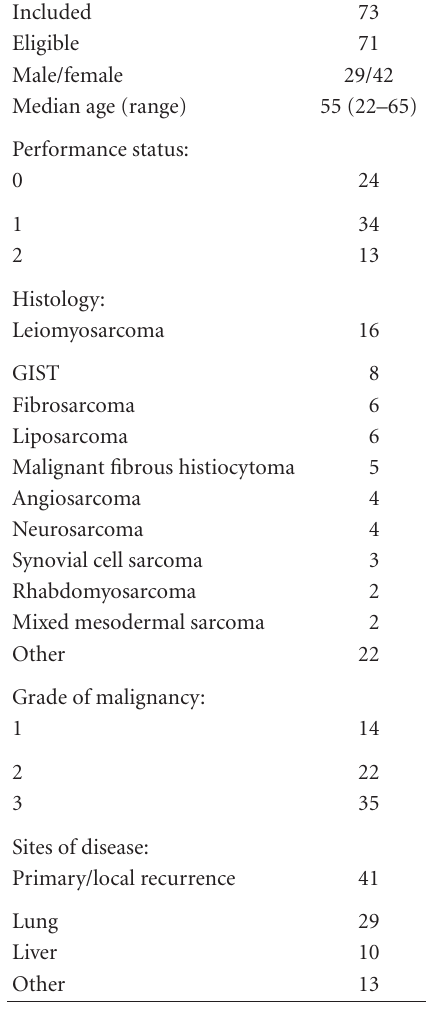
Table 1: Patient